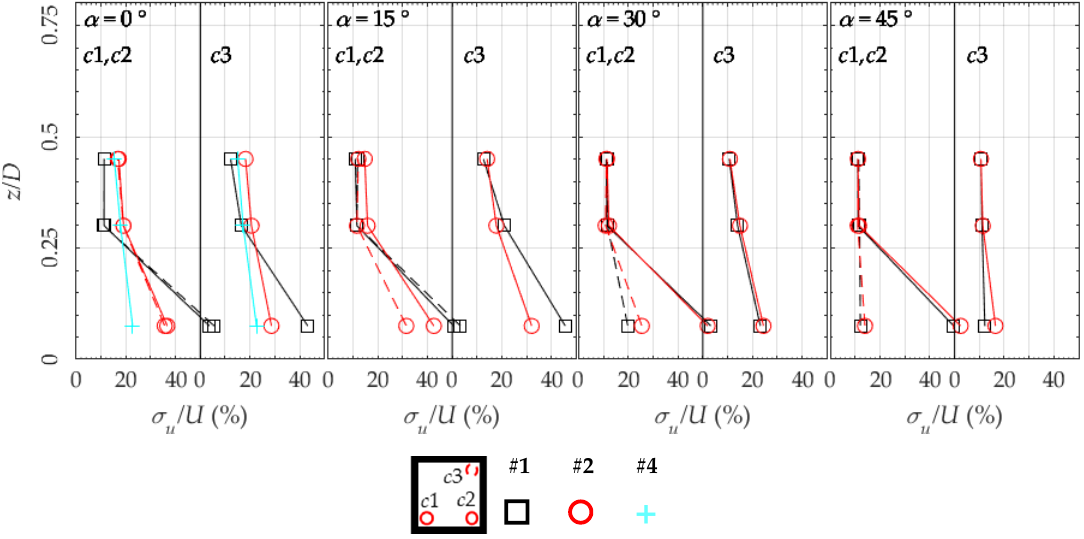
Figure 11. Longitudinal turbulence intensity I u at windward ( c 1, c 2) and leeward ( c 3) corner locations. Symbols as indicated in the legend, for the configurations #1, #2, #4 and wind